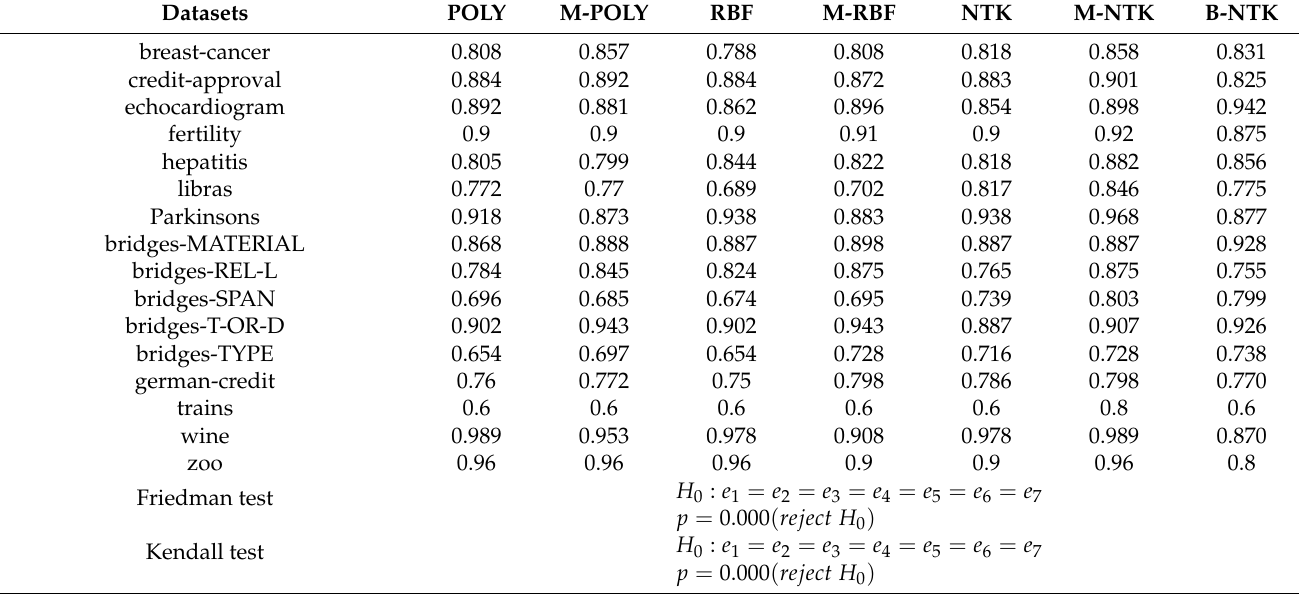
Table 2. Comparison of model results for selected